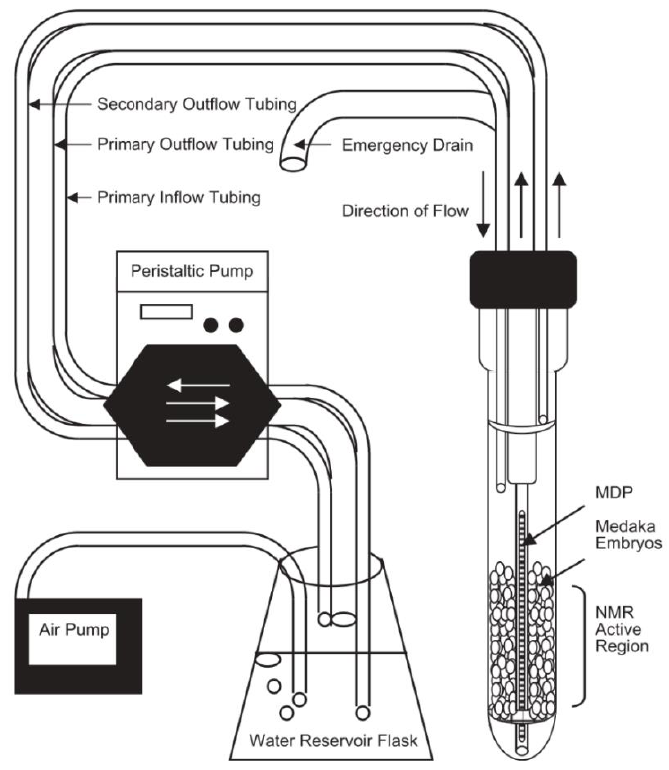
Figure 2. Example of one of the first flow systems for solution state NMR created by Pincetich et al. to keep Medaka embryos alive during the experiment in a 10 mm probe. Reproduced with permission from Elsevier [119].